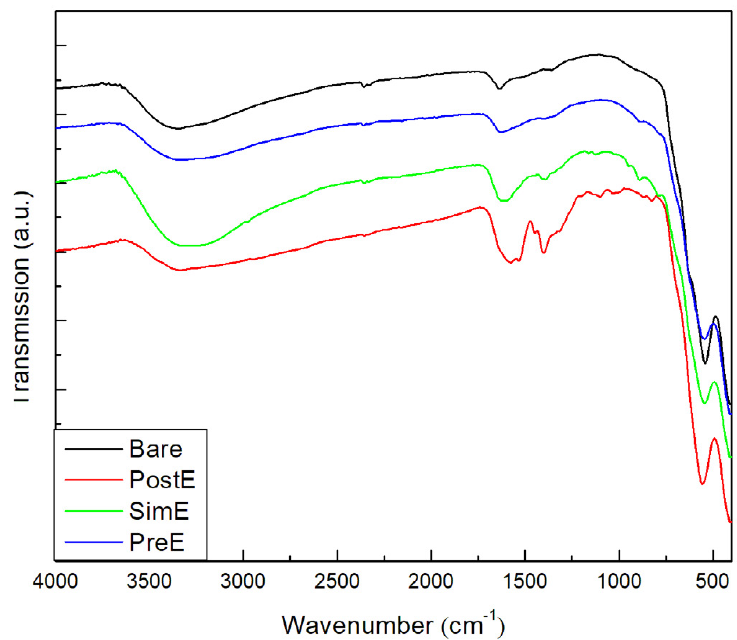
Fig. 6. FT-IR spectra of the bare nanoparticles and the L-glutamic acid series of capped